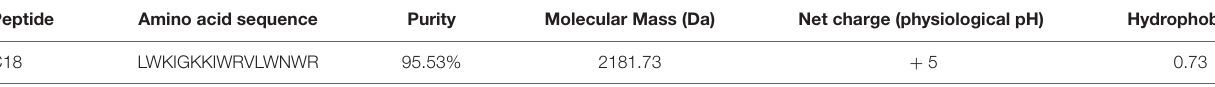
TABLE 1 | Amino acid sequence and physicochemical properties of C18. Peptide Amino acid